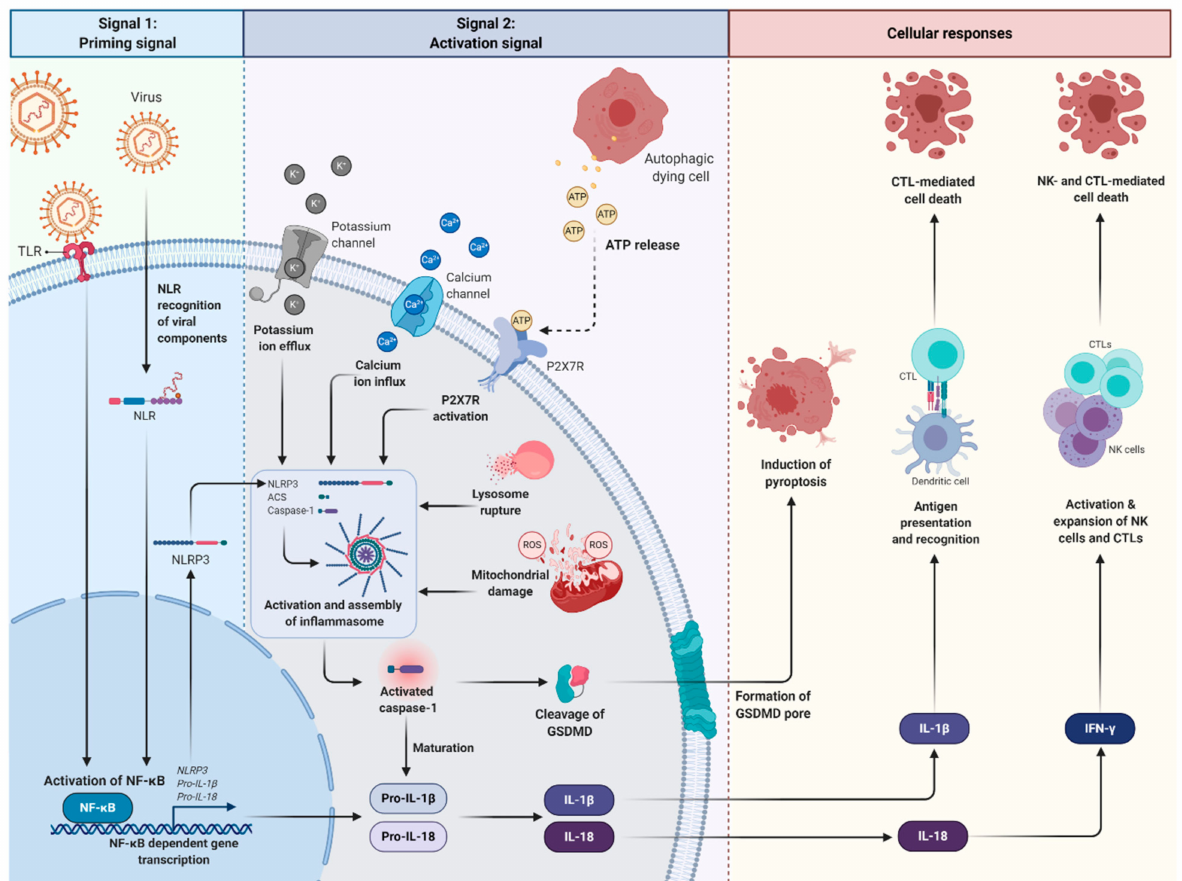
Figure 2. An overview of canonical inflammasome activation during Epstein–Barr virus (EBV) infection. The viral constituents can serve as a PAMP and be recognised by PRRs such as TLR and NLR. As such, TLR/NLR can recognise EBV during infection. The interaction of viral components with TLRs or NLRs results in the transcription and expression of the NLRP3 inflammasome, pro-IL-1 β and pro-IL-18 via NF- κ B activation (signal 1). An additional stimulus (signal 2) induced by cytosolic danger signals (referred to as DAMPs), such as lysosomal damage, mitochondrial ROS, potassium efflux and calcium ion influx, is usually required for the production and subsequent extracellular release of IL-1 β and IL-18. Moreover, the binding of ATP released from autophagic dying cells to P2X7R induces P2X7R activation and subsequent potassium ion efflux and calcium ion influx. Together, these signals promote assembly of the NLRP3 inflammasome to ASC which then recruits pro-caspase-1 via its CARD. This leads to the oligomerisation and activation of the inflammasome complex. The inflammasome complex triggers the cleavage of pro-caspase-1 into caspase-1, and subsequent maturation of pro-inflammatory cytokines. Activated caspase-1 induces pyroptosis of infected cells via cleavage of GSDMD. On the other hand, IL-1 β and IL-18 are important mediators of innate and adaptive immune response. (PAMP, pathogen-associated molecular pattern; TLRs, toll-like receptors; NLRs, NOD-like receptors; IL-1 β , interleukin-1 β ; IL-18, interleukin-18; NF- κ B, nuclear factor kappa B; DAMPs, damage-associated molecular patterns; ROS, reactive oxygen species; ATP, adenosine triphosphate; P2X7R, P2X7 purinergic receptor; NLRP3, NOD-like receptor pyrin domain containing 3; ASC,